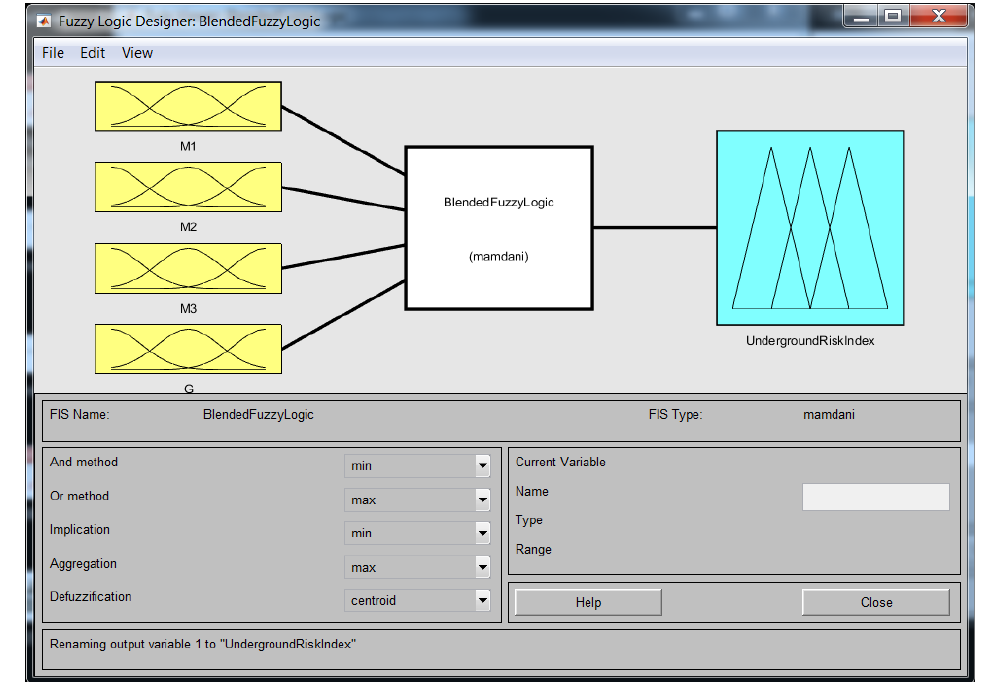
Figure 10. Mamdani fuzzy inference system for top-level fuzzy logic.